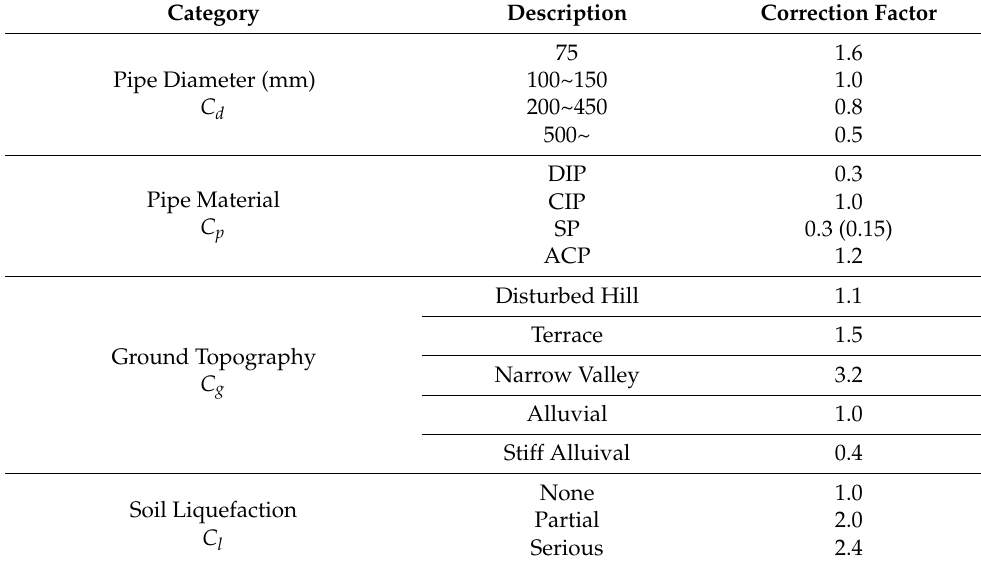
Table 3. Correction factors to RR